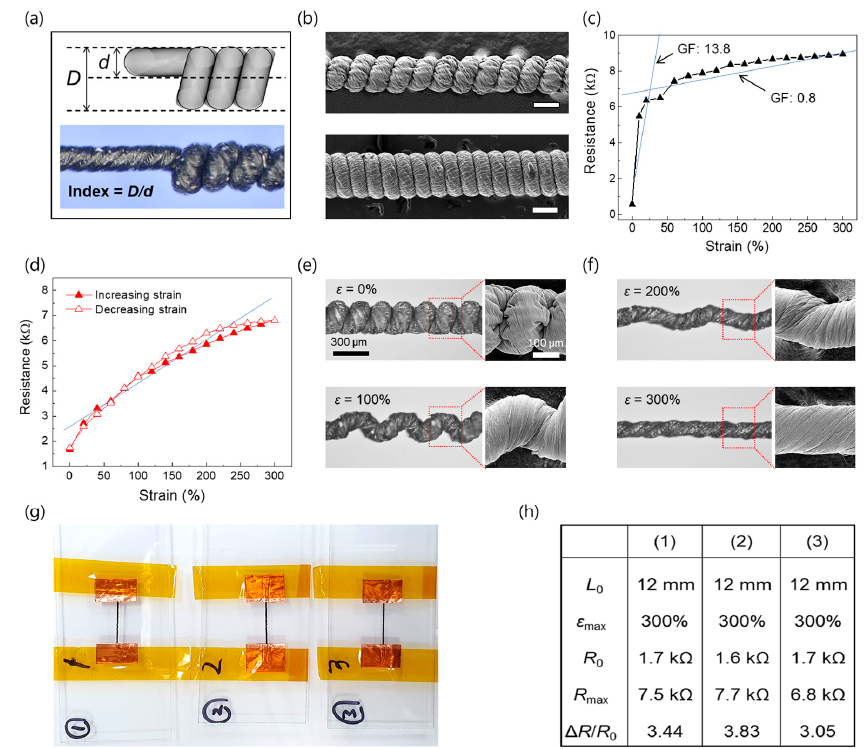
Figure 2. Electromechanical response and coil loop opening characteristics ( a ) Schematic ( above ) and photograph ( below ) of the definition of the coil index, which can be calculated by dividing the average diameter of the coil fiber ( D ) by the diameter of the precursor fiber ( d ). ( b ) Scanning electron microscopy (SEM) images of coiled CNT/polymer fiber sensors with low ( above : scale bar = 200 µ m) and high indexes ( below : scale bar = 300 µ m). Resistance changes versus strain of coiled CNT/polymer fiber with ( c ) high (2.9) and ( d ) low index (1.9). The slope of the blue lines represents the piezoresistive sensitivity (i.e., GF). Photographs and magnified SEM images show progressive coil loop opening at ( e ) 0% and 100%, and surface buckles unfolding at ( f ) 200% and 300% strains. ( g ) Photograph of three coiled CNT/polymer fiber sensors (length: 1.2 cm). The table in ( h ) lists the performance characteristics of the three fiber